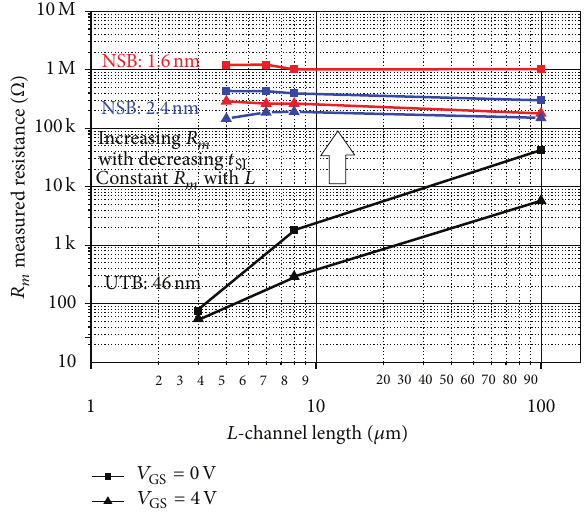
Figure 4: Comparison of the measured resistance 𝑅 𝑚 for NSBs devices having a channel thickness of 1.6 and 2.4nm, with UTBs devices (46nm channel thick), as a function of Channel Length (𝐿) positive and several 𝑉 GS